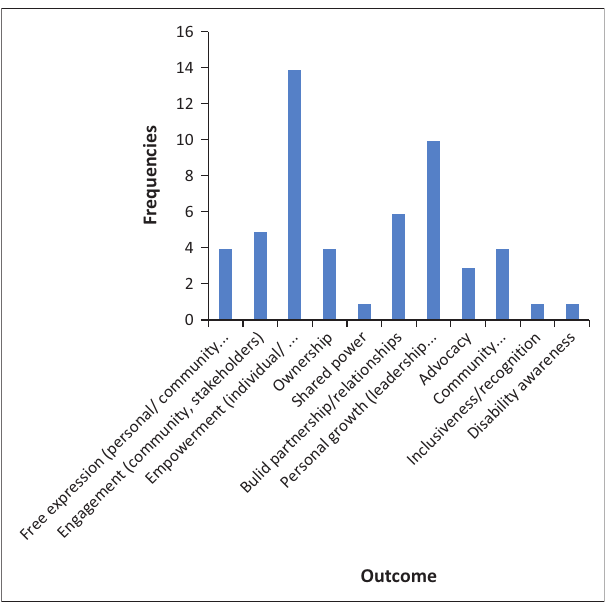
FIGURE 3: Research outcomes. TABLE 4: Subject areas addressed in line with Community Based Rehabilitation Matrix (WHO et al.